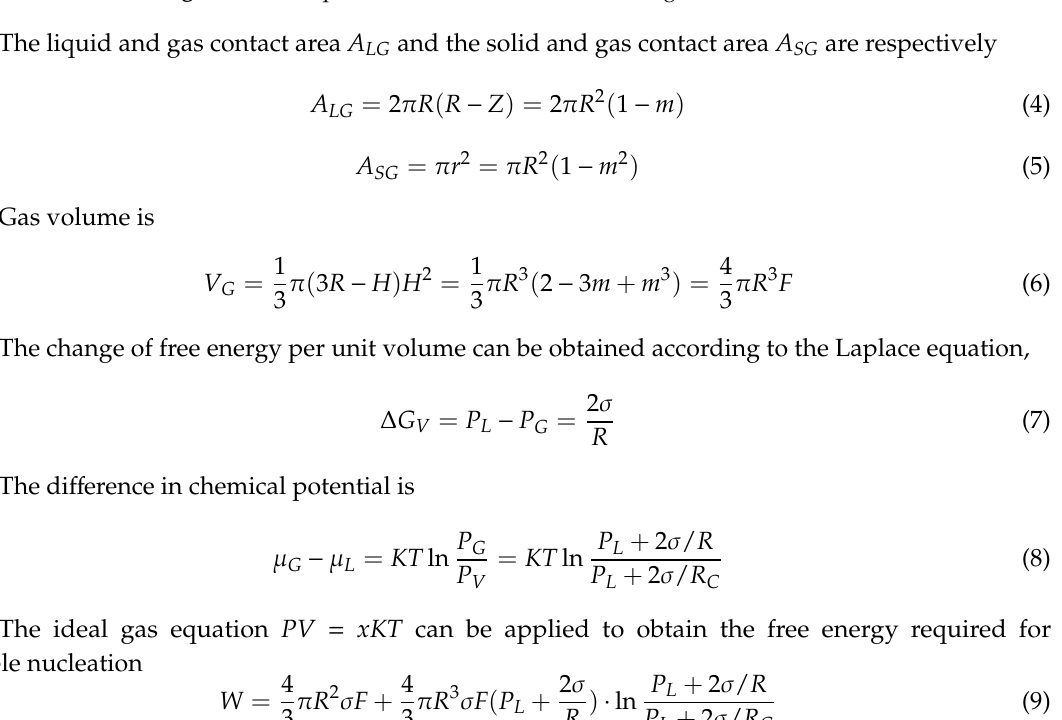
Figure 1. Gas-liquid–solid interface and contact angle of the bubble.